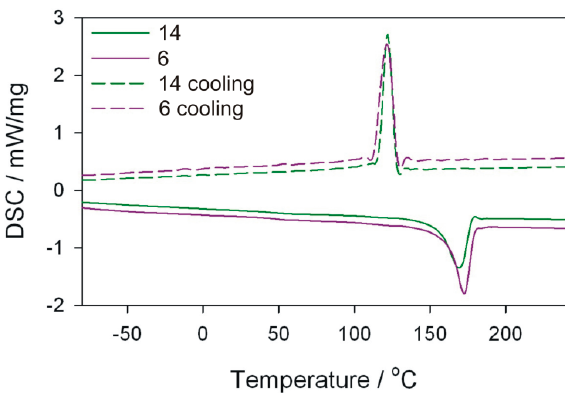
Figure 16. DSC curves for extrudate samples–layouts 6 and 14. Sample designations as in Table 1.